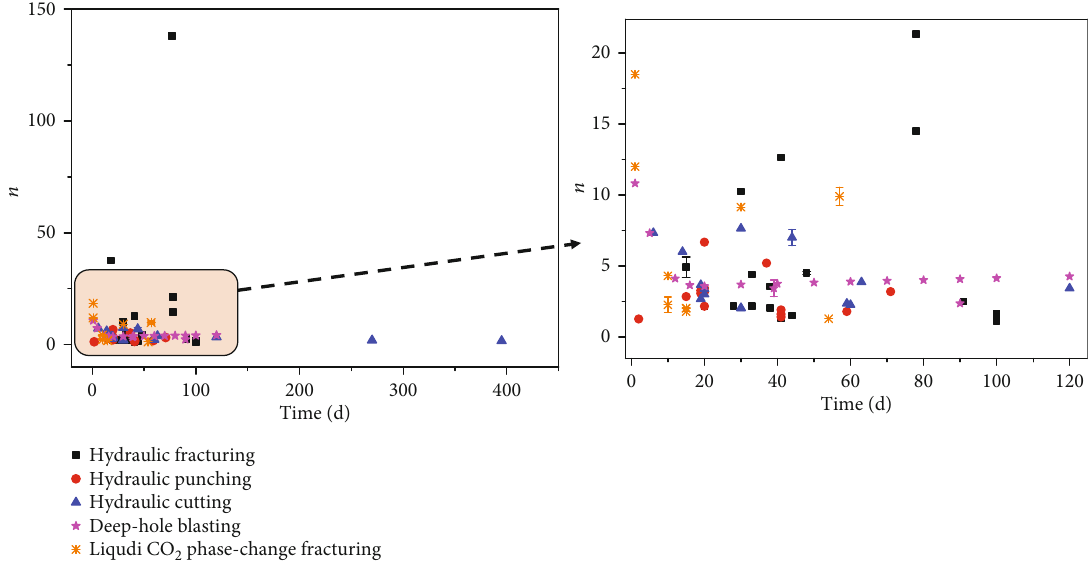
Figure 21: The growth multiples of average gas fl ow for di ff erent stimulation techniques (the data come from the literatures [64, 133 – 161]). Table 5: Data sources of fi eld-scale stimulation e ff ectiveness. Stimulation method Data